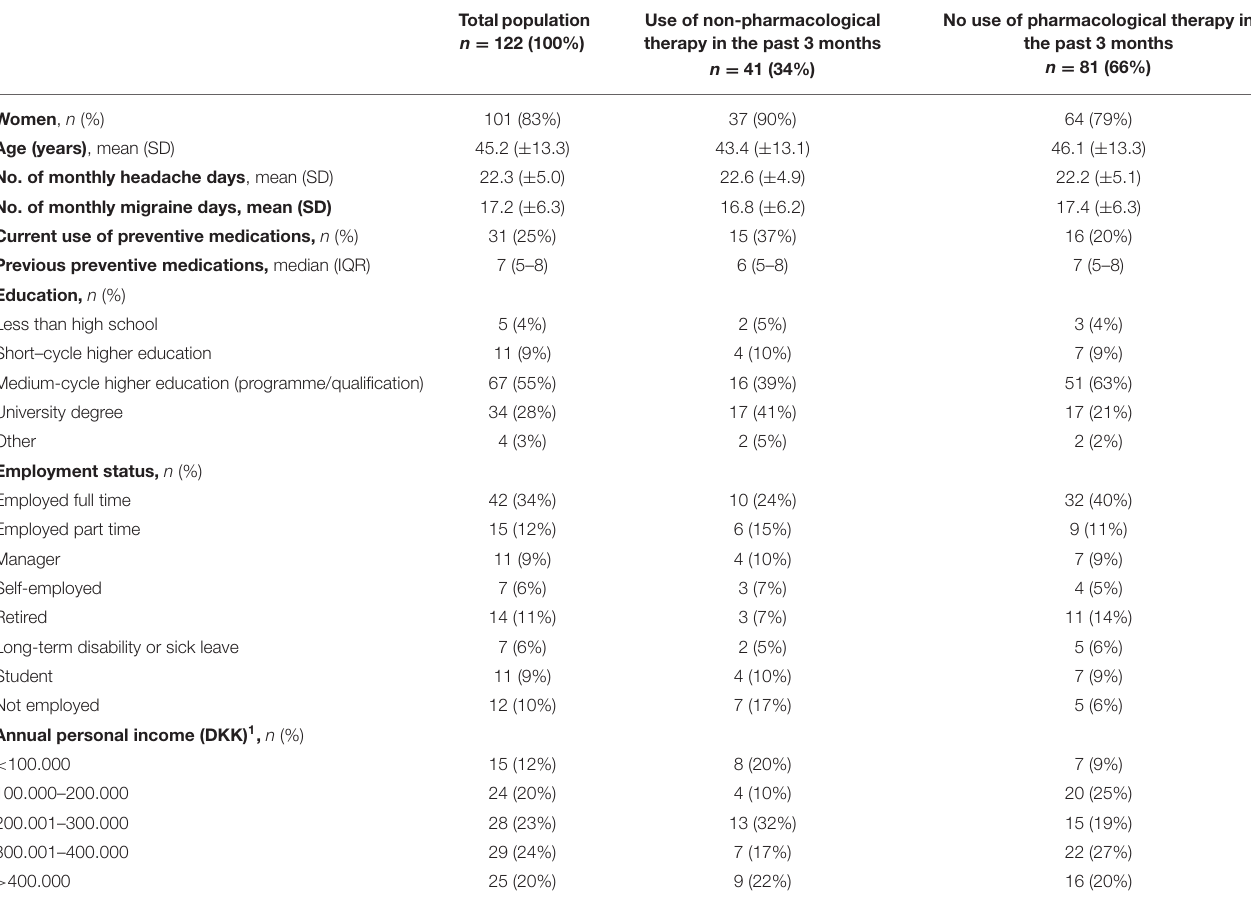
TABLE 1 | Sociodemographic and migraine-related characteristics of participants using and not using non-pharmacological therapies.